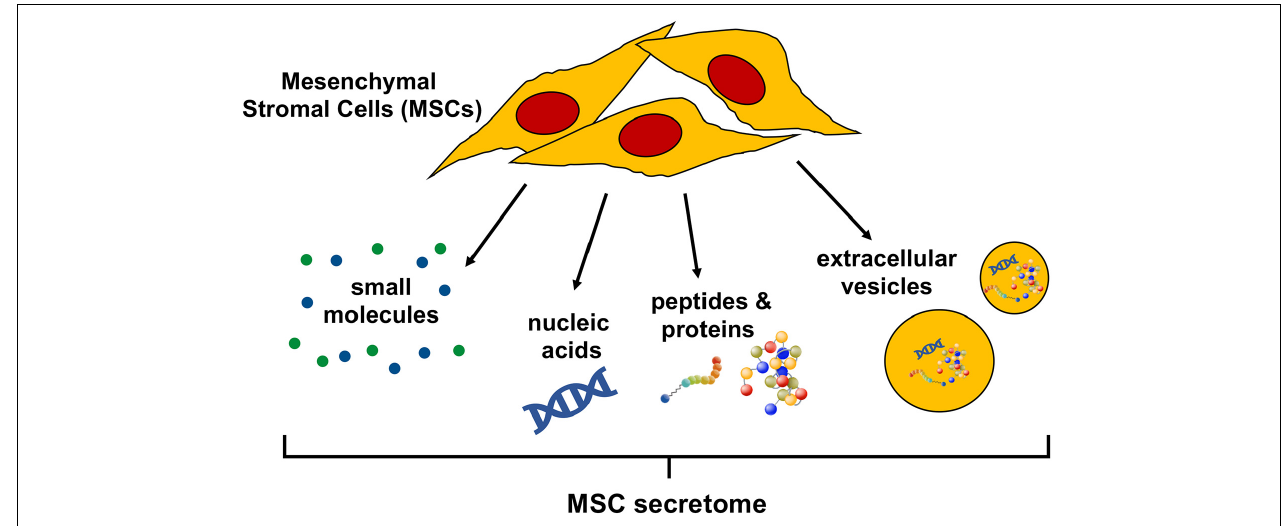
FIGURE 1 | Bioactive components of the mesenchymal stromal cell (MSC) secretome. The MSC secretome is comprised of all factors secreted by MSCs. The bioactive components of the secretome include a wide range of small molecules, nucleic acids (importantly, regulatory RNAs), peptides, and proteins. These molecules can either be released freely or packaged in extracellular vesicles, which are lipid bilayer-delimited particles of various size and